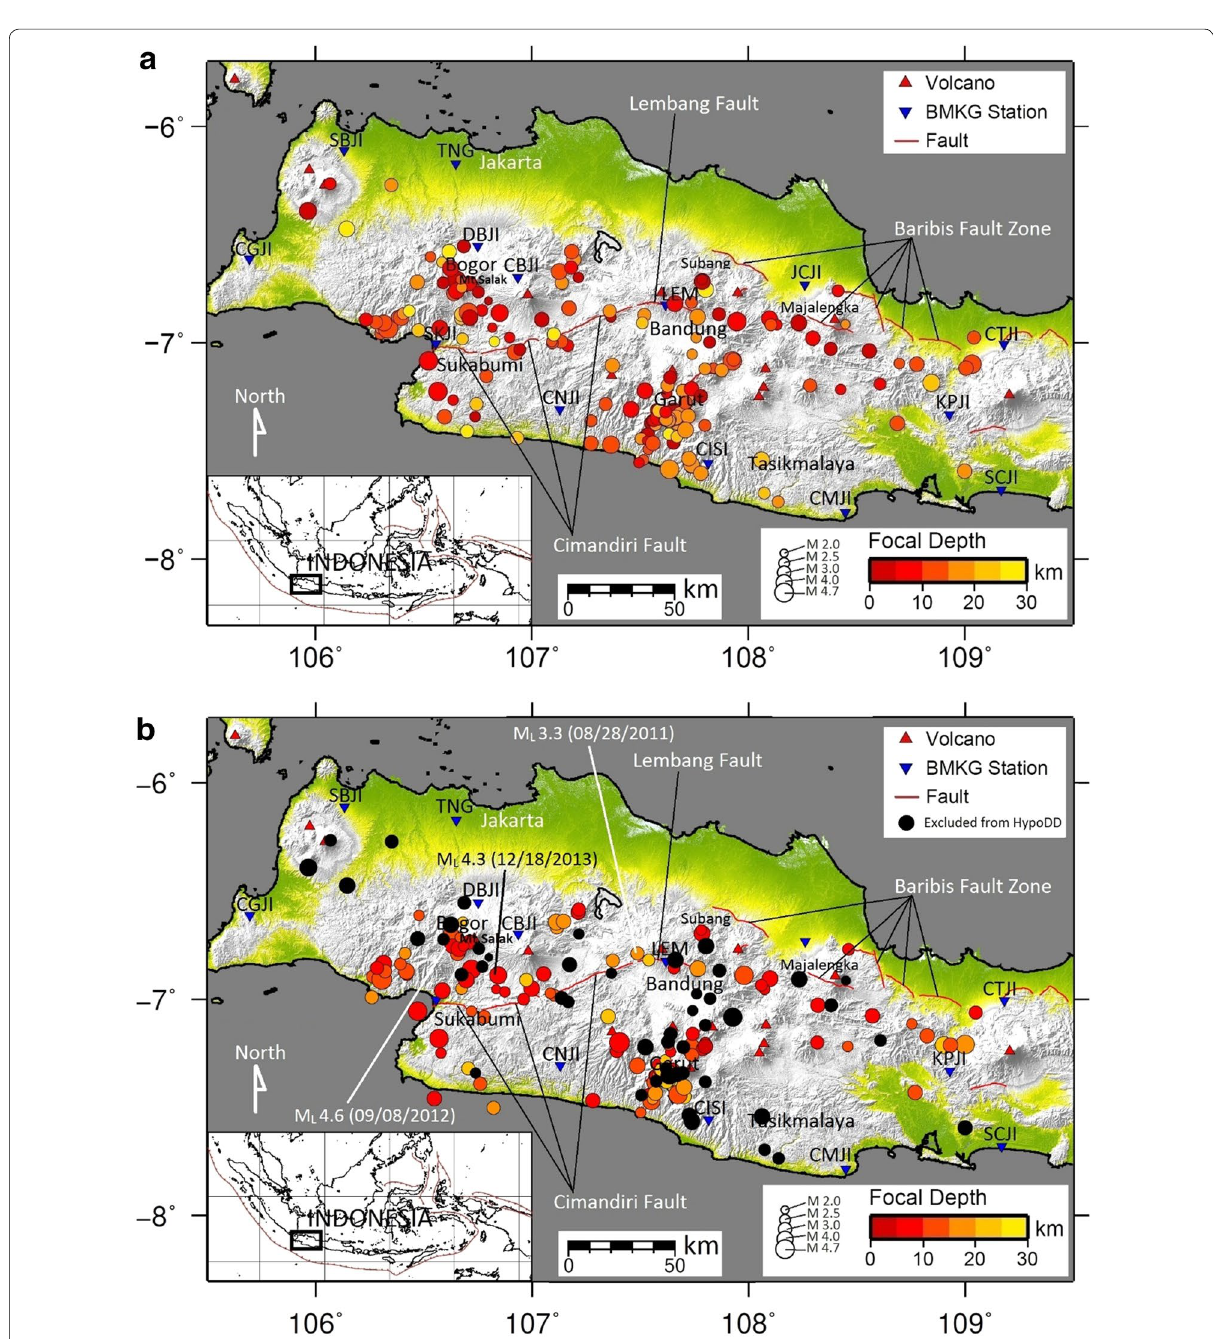
Fig. 2 Map of the shallow earthquakes (depths less than 30 km) in West Java in the period from 2009 to 2015. a Initial earthquake locations/ before relocation. b After relocation; there are 168 and 117 events, respectively. Colored dots depict the distribution of epicenters. Black dots depict earthquakes excluded from HypoDD. Blue inverted triangles show the BMKG seismic stations; red triangles depict volcanoes, and the red line depicts a fault from Irsyam et al.